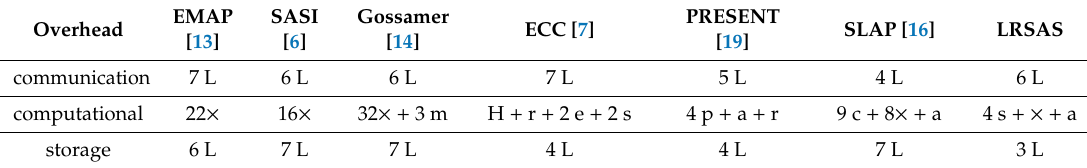
Table 5. Performance